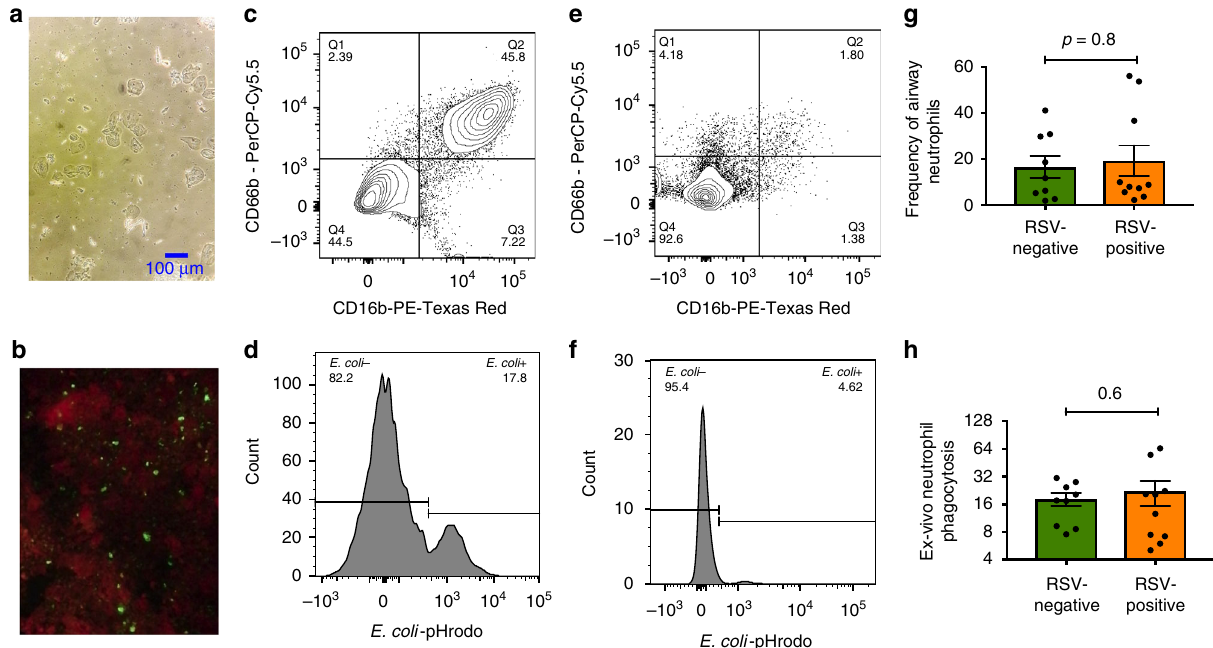
Fig. 4 Analysis of the cellular sources of the airway proteome by fl ow cytometry. a Cells obtained from nasopharyngeal and oropharyngeal swabs (both eluted in universal transport media) from a child with an RSV infection was visualised at ×200 magni fi cation. Multiple cell morphologies including epithelial cells were observed. b Upper airway sample obtained from an infant admitted to hospital with RSV-pneumonia was analysed using a direct immuno fl uorescent antibody test 38 (Light Diagnostics, Merc). RSV-infected cells are shown emitting an apple-green fl uorescent signal, while